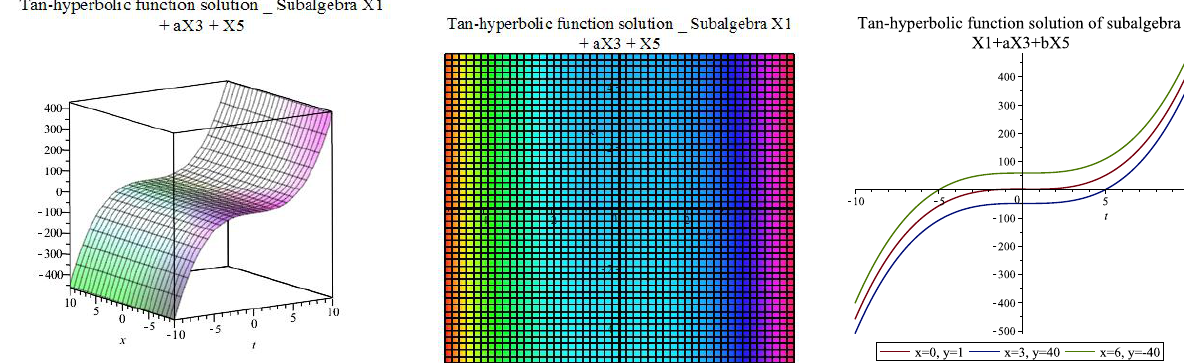
Figure 11. Solitary wave depiction of hyperbolic function solution (72) at y =